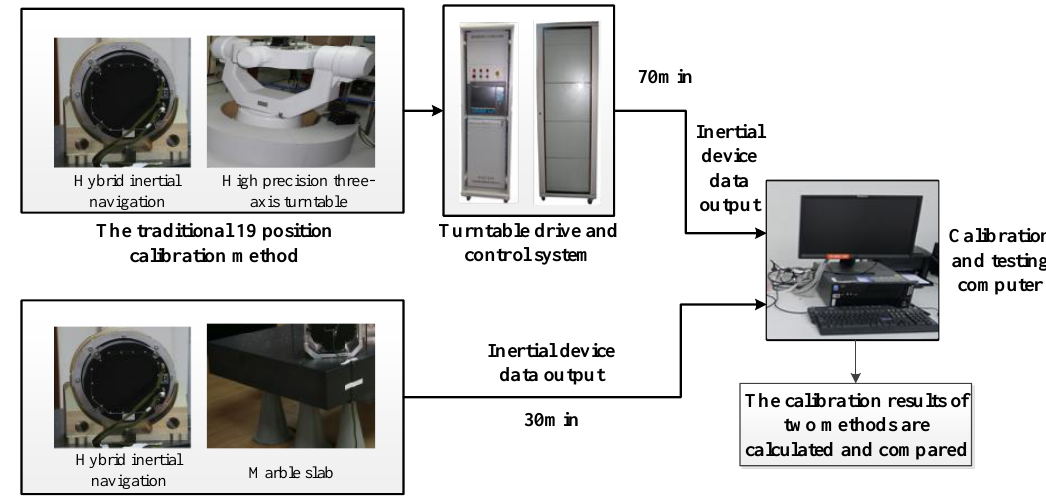
Figure 6. Experiment system composition.